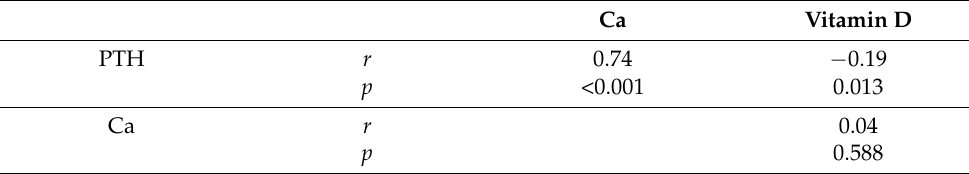
Table 7. Differentiation of CTX, osteocalcin and PTH depending on disease activity in CD.